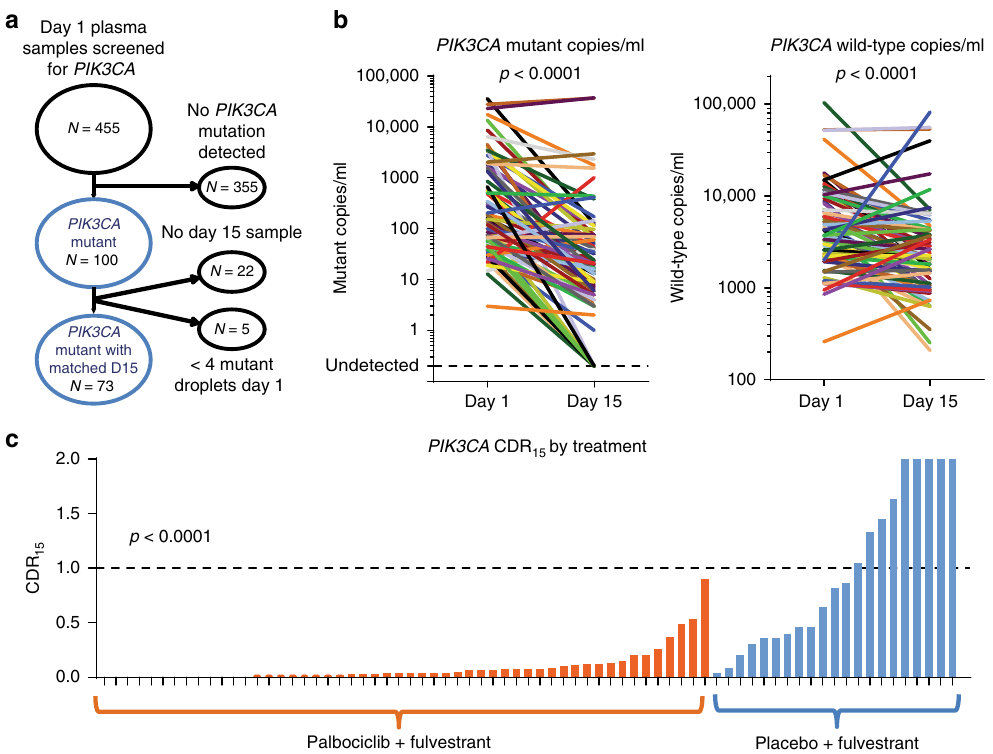
Fig. 1 Palbociclib and fulvestrant suppresses ctDNA after two weeks of treatment. a CONSORT diagram of plasma samples analyzed from PALOMA-3 for PIK3CA mutation with droplet digital PCR assays. b Dynamics of PIK3CA mutant and wild-type DNA copies/ml between day 1 and day 15 of treatment, n = 73, median day15:day1 ratio for mutant 0.076, median ratio for wild-type 0.54, p < 0.0001, Wilcoxon signed-rank test. c Circulating DNA ratio day15 copies/ml relative to day 1 copies/ml (CDR 15 ) for circulating PIK3CA mutation split by treatment. p value Mann – Whitney test comparison between treatments. Lines are at